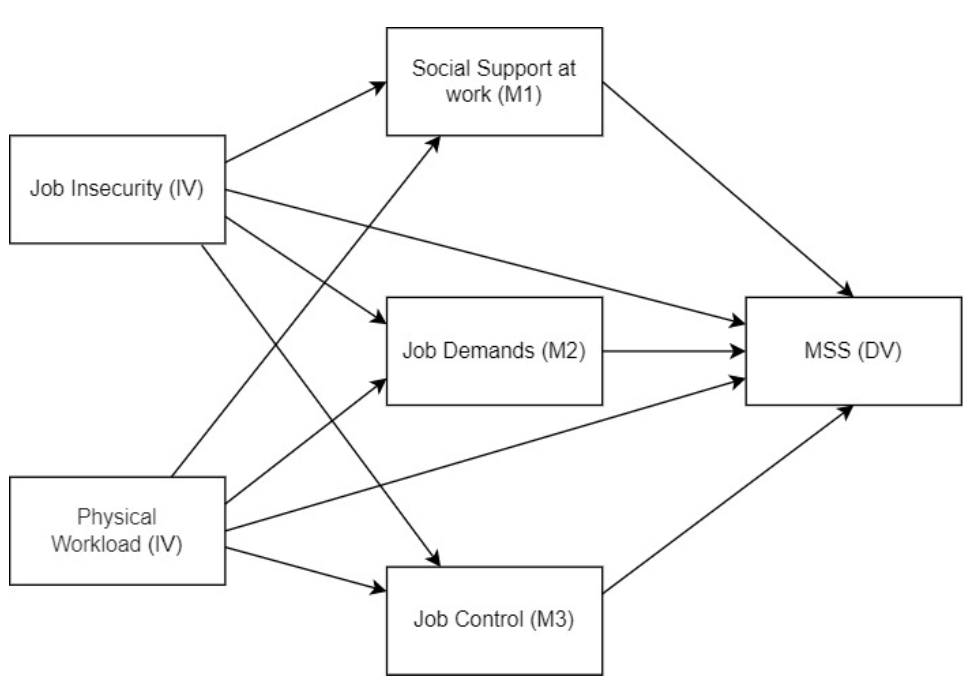
Figure 1. Hypothesized parallel mediation model. IV: Independent Variable; M: Mediator; MSSs: Musculoskeletal